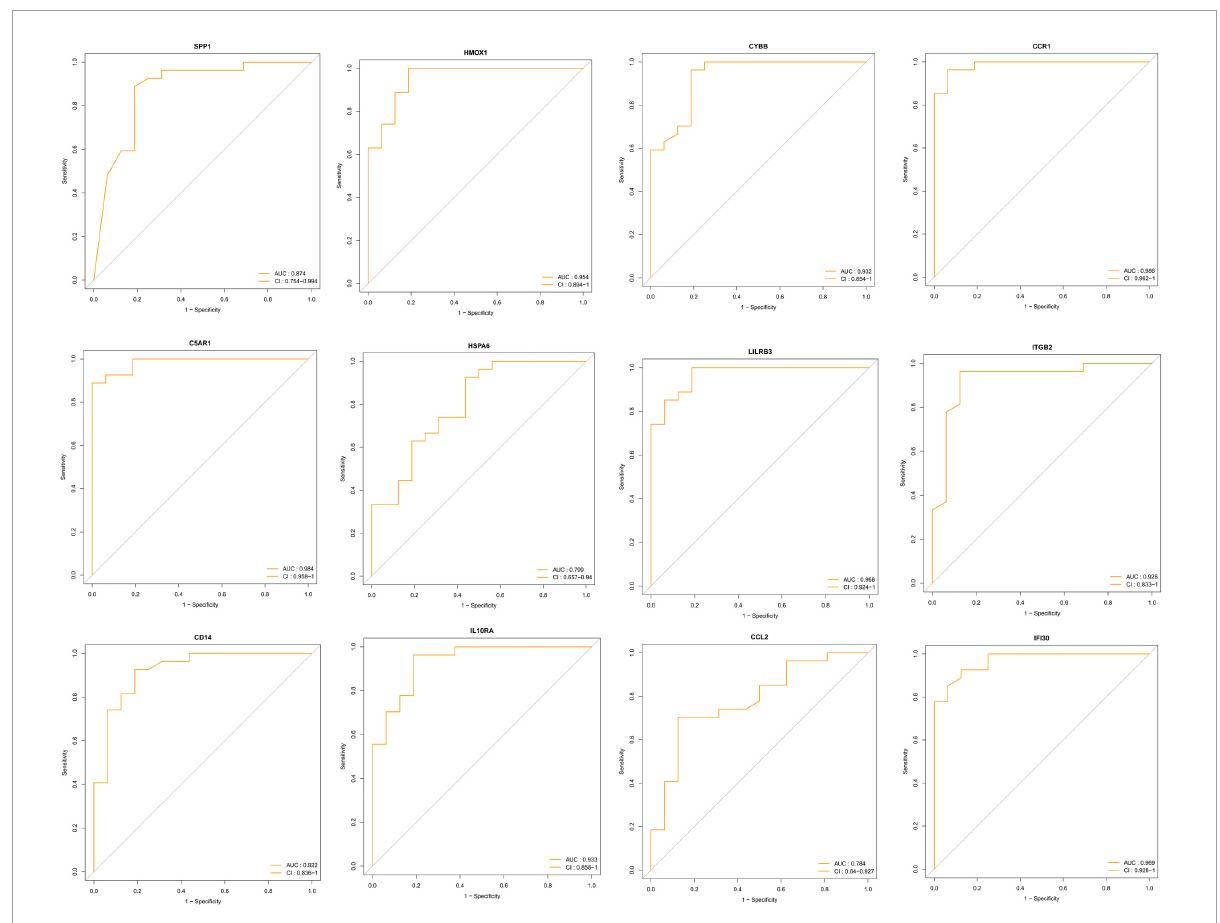
FIGURE9 Receiver operating characteristic (ROC) analysis of differentially expressed immune-related genes in the carotid plaque